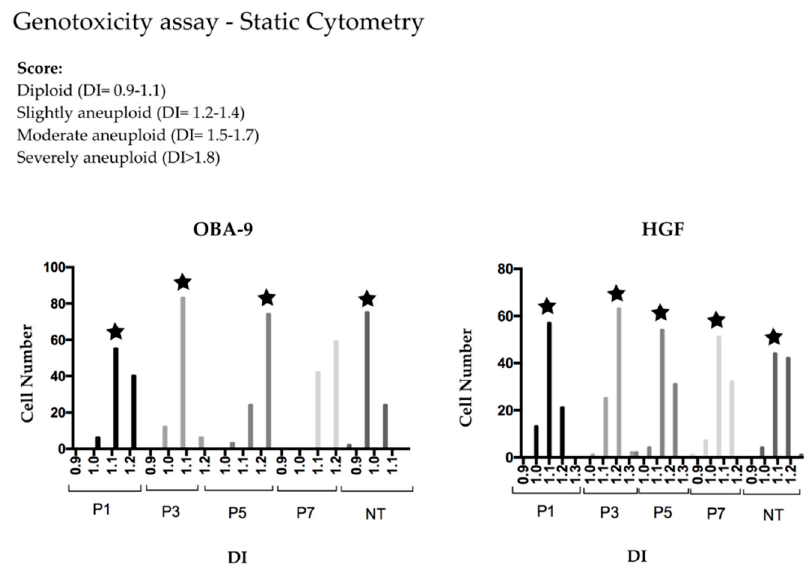
Figure 3. Frequency histogram of the obtained DNA index (DI) for OBA-9 and HGF cells. P#—minutes of plasma treatment; NT—not-treated; star represents the DI peak in each group.